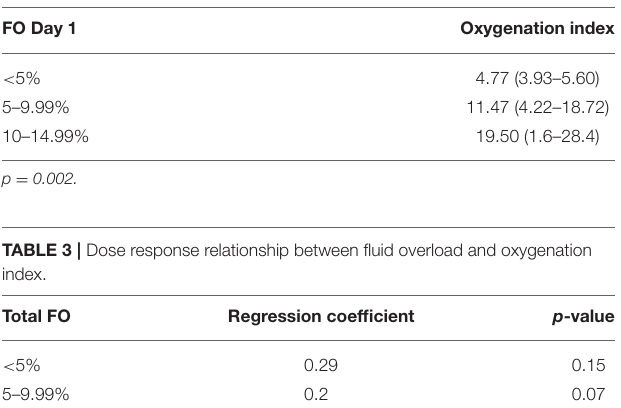
TABLE 4 | Maximum fluid overload and PELOD score as predictors of peak oxygenation index.